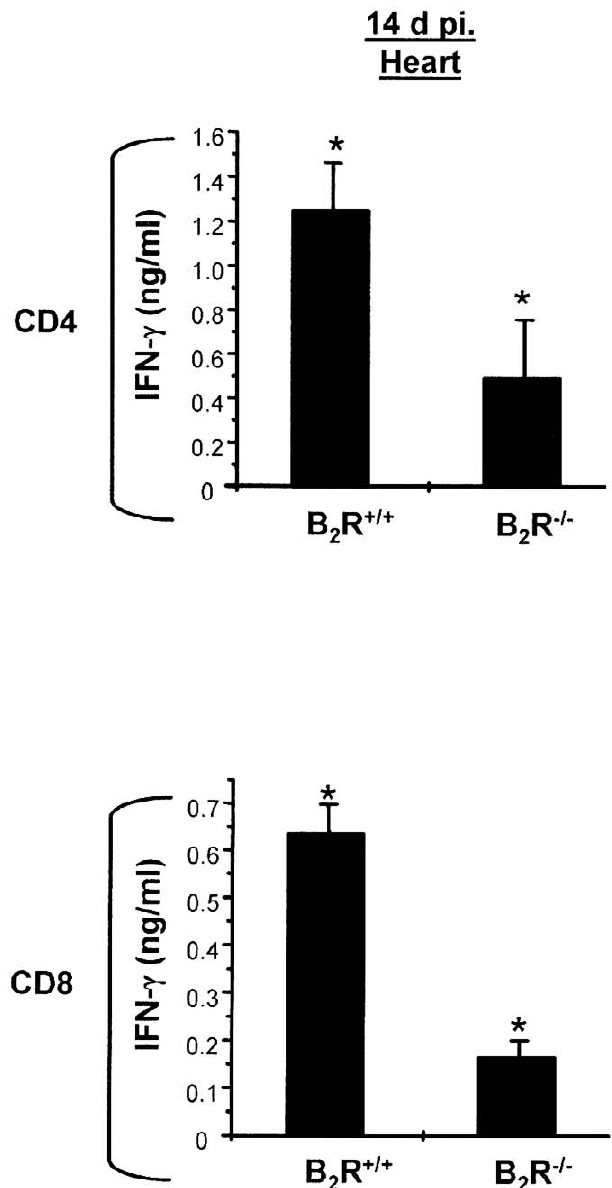
Figure 4. B 2 R (cid:2) / (cid:2) -Infected Mice Present Lower Frequencies of IFN- c - Producing Intracardiac CD4 þ and CD8 þ T Cells at the Early Stage (14 d p.i.) of Infection Assessment of IFN- c production by heart-derived CD4 þ and CD8 þ T cells isolated (14 d p.i.) from B 2 R þ / þ and B 2 R (cid:2) / (cid:2) mice. Cells were co-cultured with CD11c þ DCs loaded with T. cruzi Ag (25 l g/ml) for 72 h at 37 8 C. Culture supernatants were harvested and assayed for IFN- c by ELISA. Data are representative of two independent experiments ( n ¼ 5 mice/ group). Statistics were done by ANOVA and pair-wise comparisons were done by the Tukey test (*, p , 0.05) .